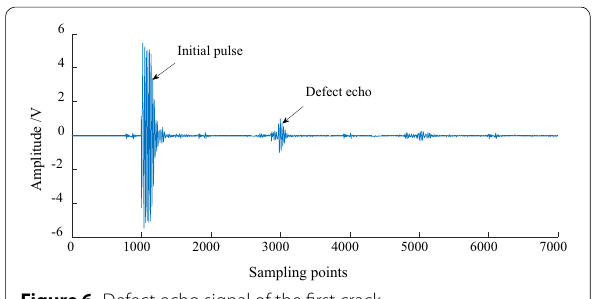
Figure 6 Defect echo signal of the first